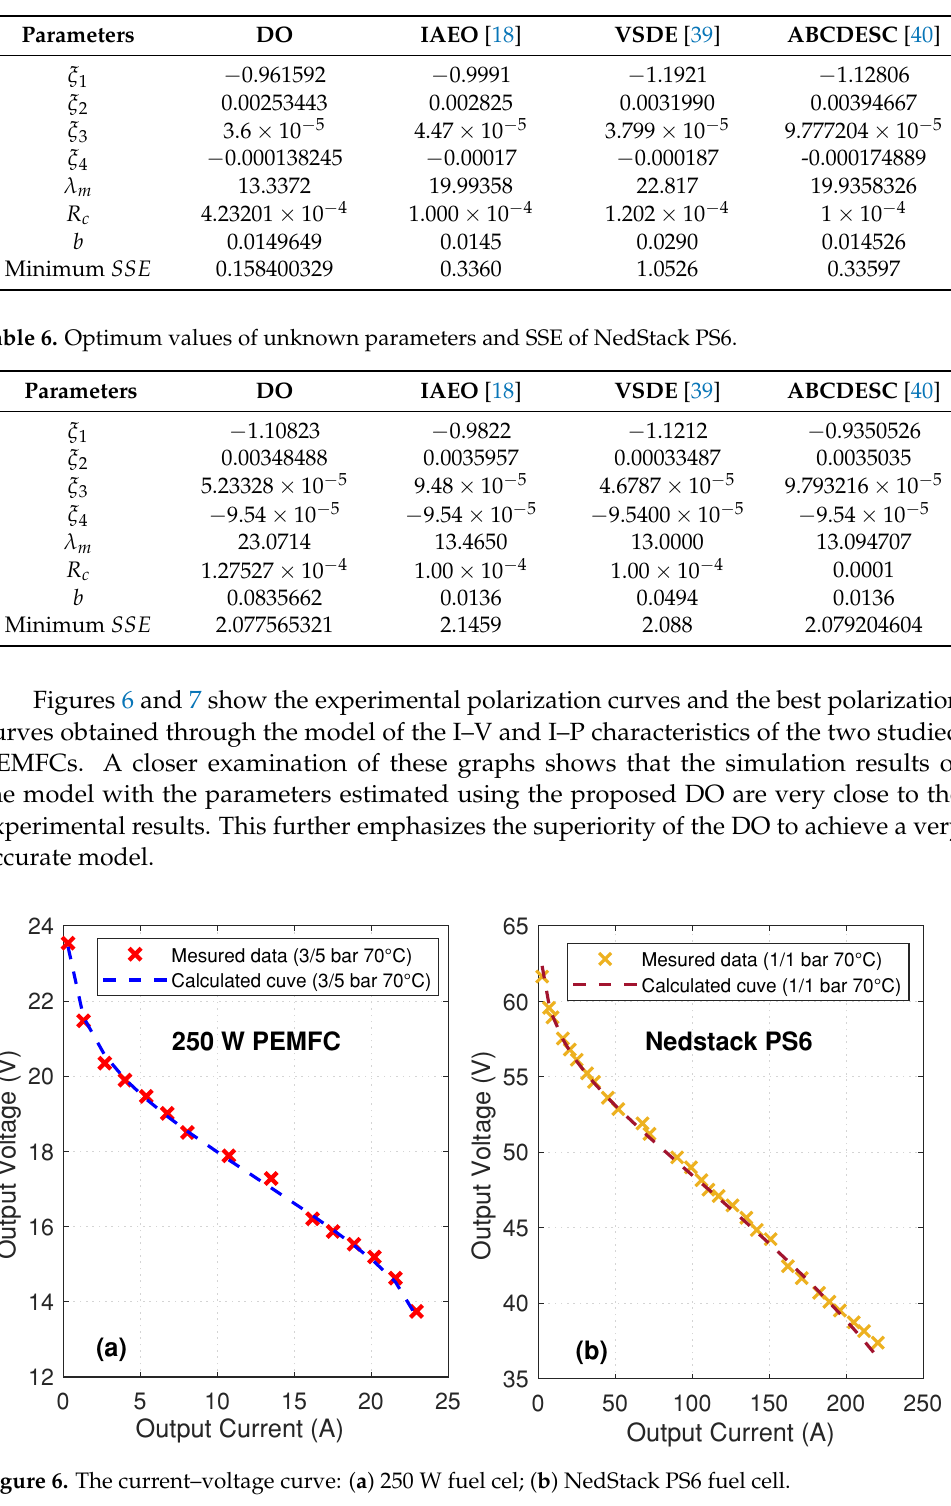
Table 5. Optimum values of unknown parameters and SSE of PEMFC 250 W.